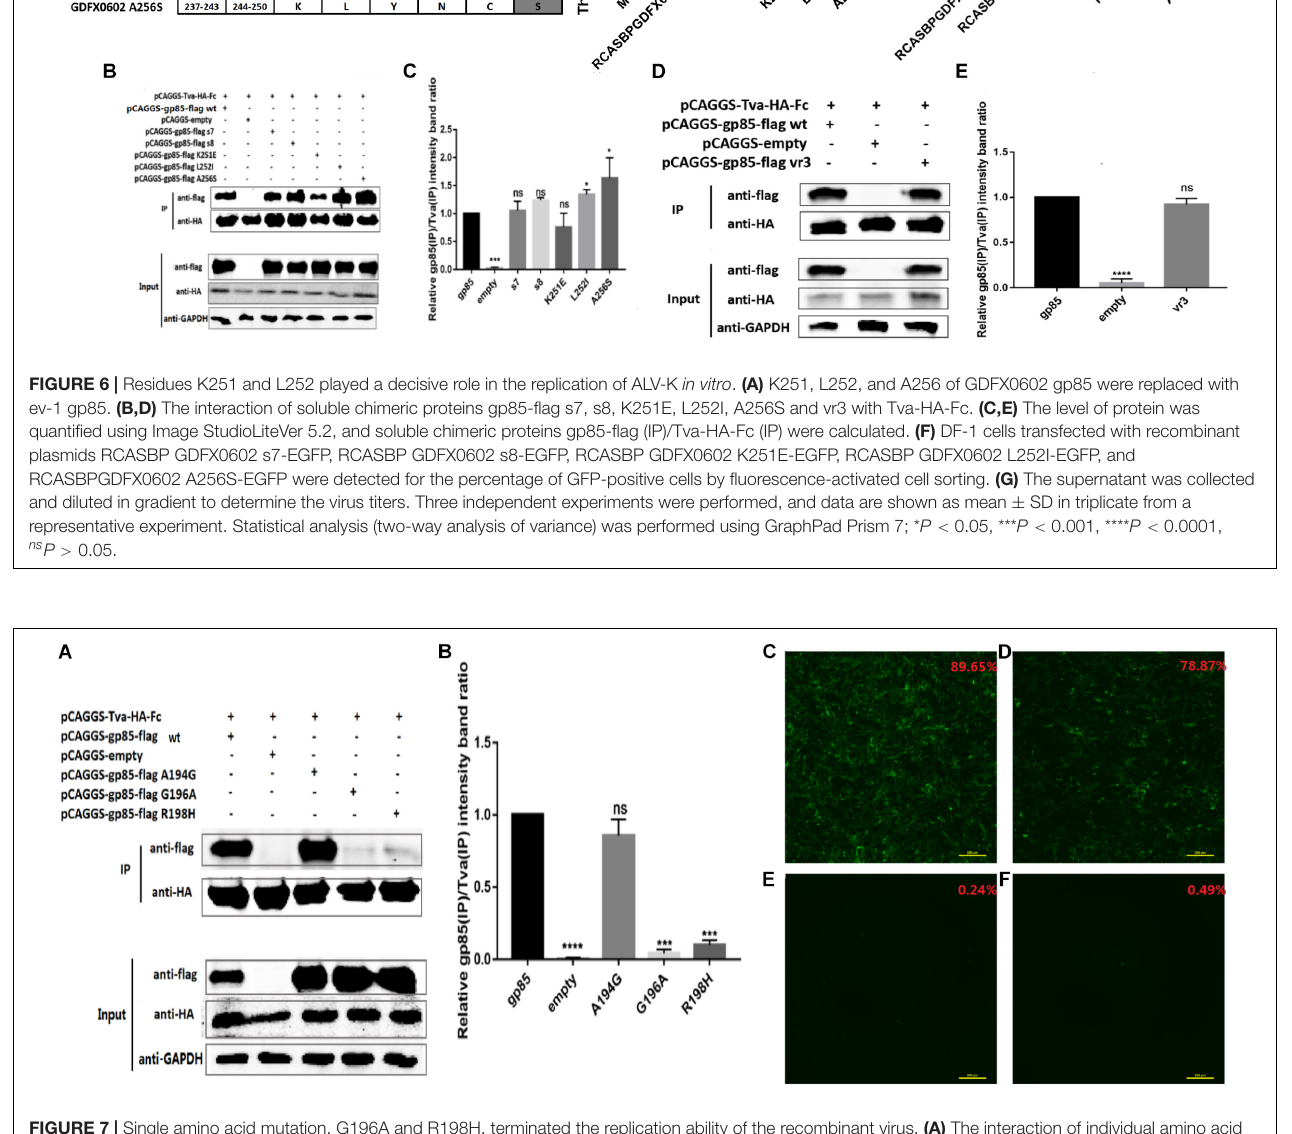
Frontiers in Microbiology | www.frontiersin.org